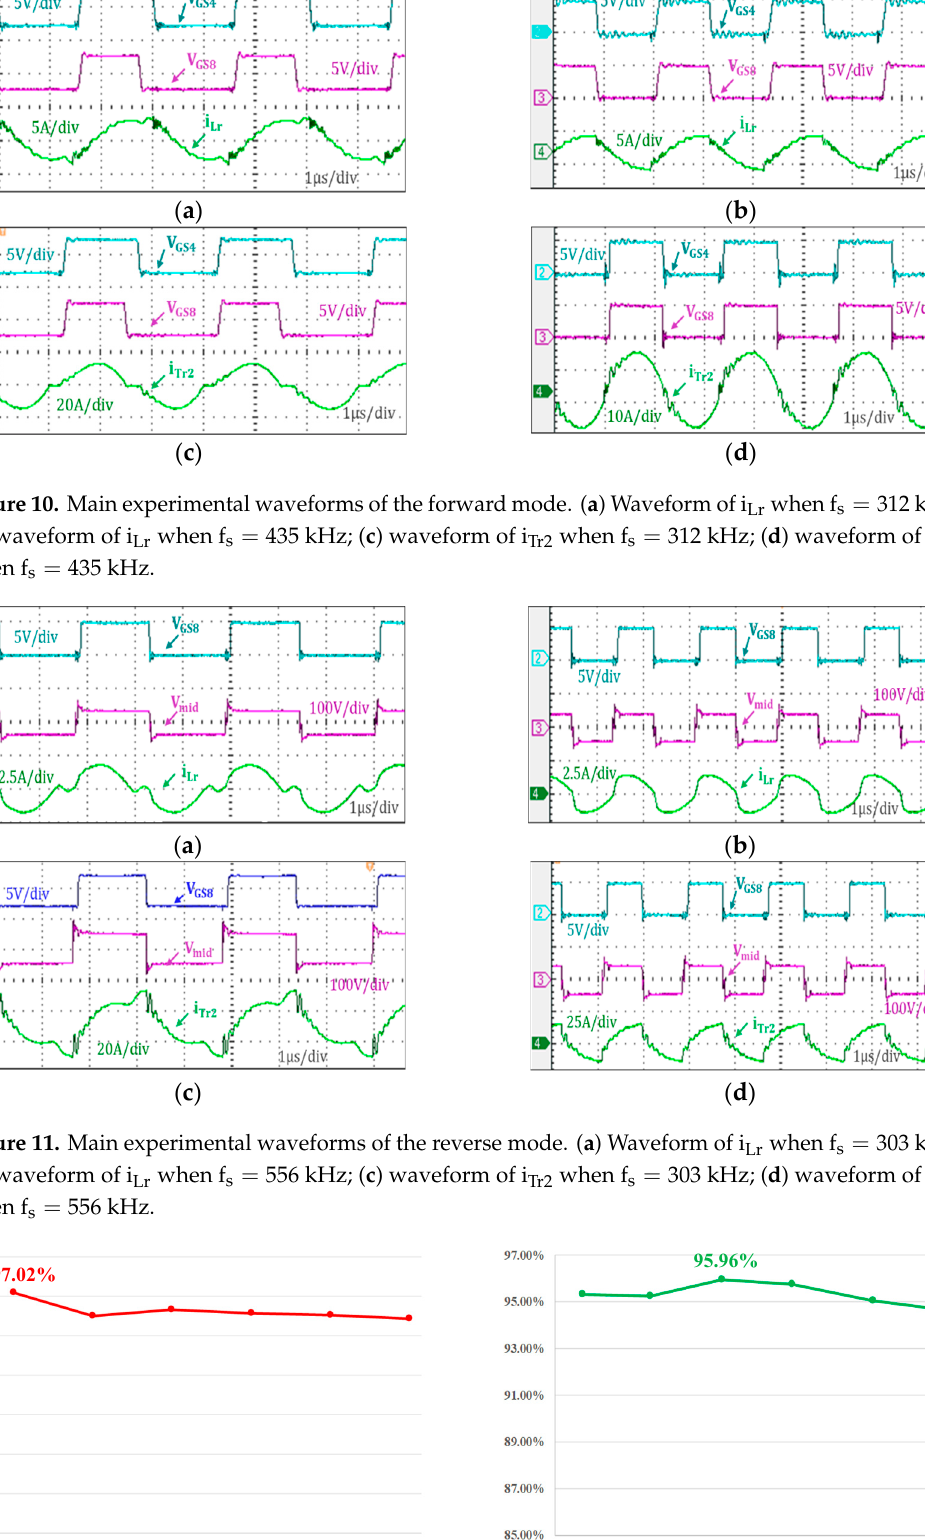
Figure 9. Structure of the prototype.